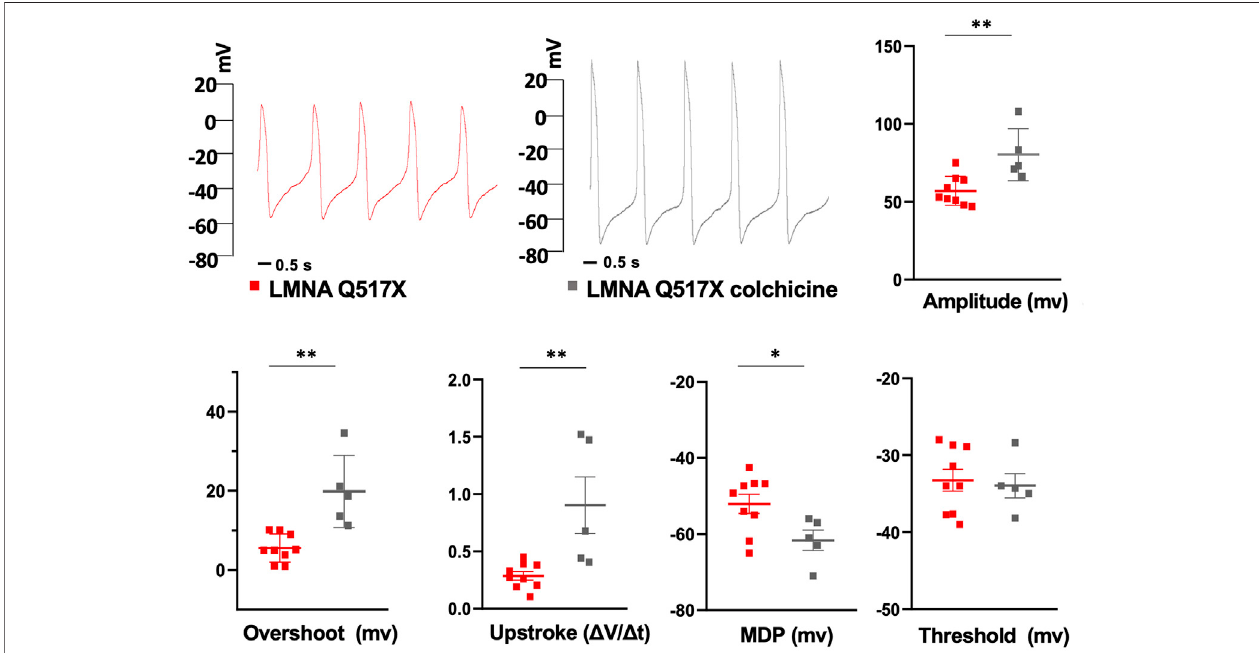
FIGURE7| RepresentativeAPrecordingsbywhole-cellpatchclampincurrentclampcon fi gurationinuntreated (redtraces)andcolchicine-treatedLMNAQ517X- expressingHL-1cells(graytraces)andscatterplotsfortheanalysisofAPparametersinuntreated (redsquares, N =9)andcolchicine-treated LMNAQ517X-expressing HL-1 cells (gray squares, N = 5). * p < 0.01, ** p < 0.001, Student ’ s t test for unpaired data.